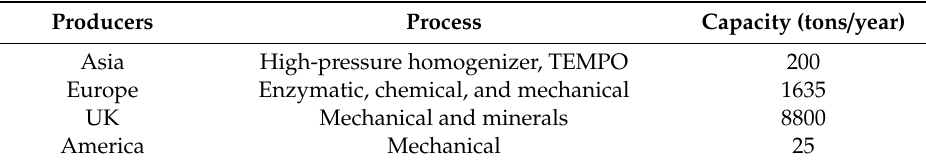
Table 3. World production of microfibrillated cellulose, 2018 (per producer).